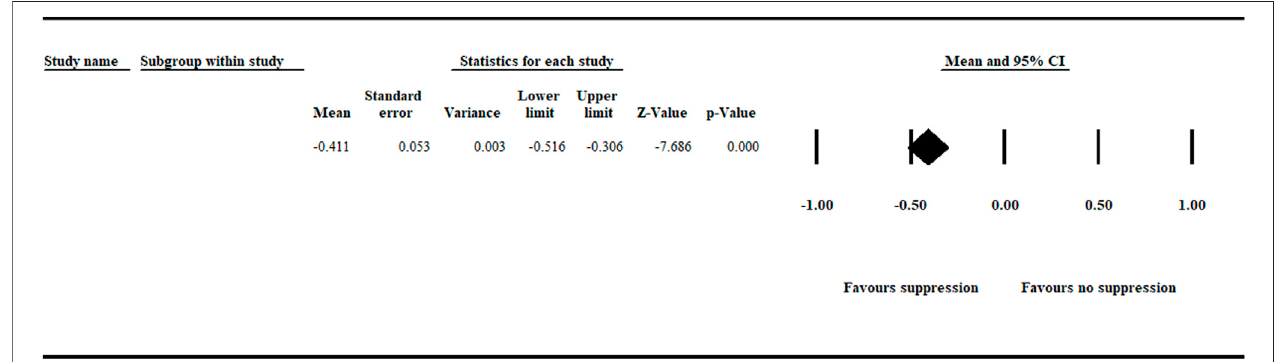
FIGURE 1 | Cumulative analysis of effect size measuring ef fi cacy on biological control of aphanomyces root rot. The analysis detected a signi fi cant ( p < .001) negativesummaryeffectsize[ − 0.411(CI − 0.516to − 0.306)]suggestingsuppressionof A.euteiches .Thecenterofthediamonddepictstheoverallmeaneffectsize,and the width re fl ects its con fi dence interval. CI (cid:1) con fi dence